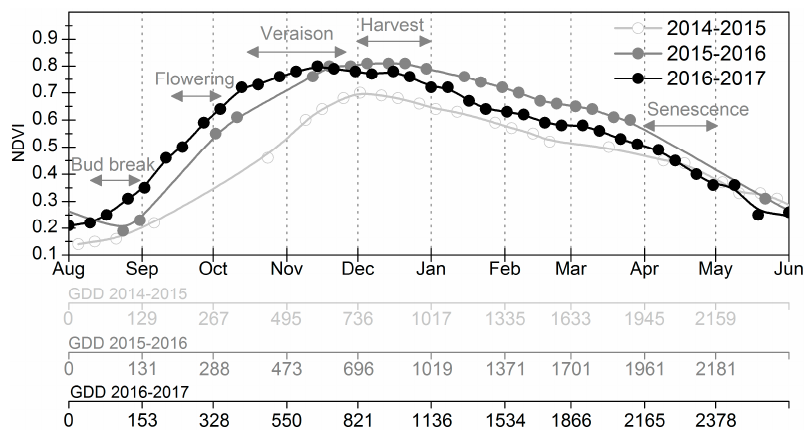
Figure 2. Evolution of the satellite normalized differences vegetation index (NDVI) values with respect to the calendar dates (upper graph). The accumulated value of growing degree-days (GDD) at the beginning of each month are presented for the monitored growing seasons (lower axis). The GDDs were calculated for a base temperature of 10 °C. The arrows indicate the main phenological stages.